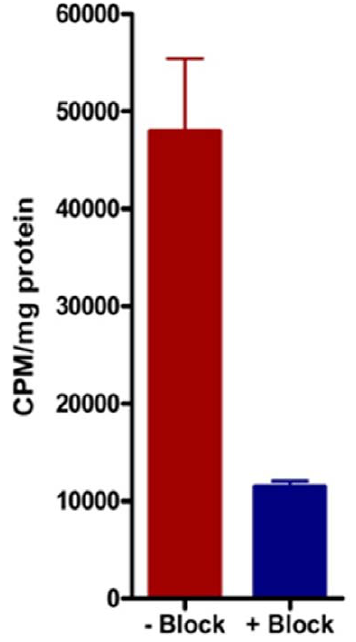
Figure 8. Cellular uptake of 64 Cu-CB-TE1A1P-LLP2A in human myeloma RPMI-8226 cells. Cell uptake of 64 Cu-CB-TE1A1P-LLP2A (0.1 nM), in human RPMI-8226 cells at 37 u C in the absence (red bar) and presence (blue bar) of excess LLP2A (P , 0.0001).